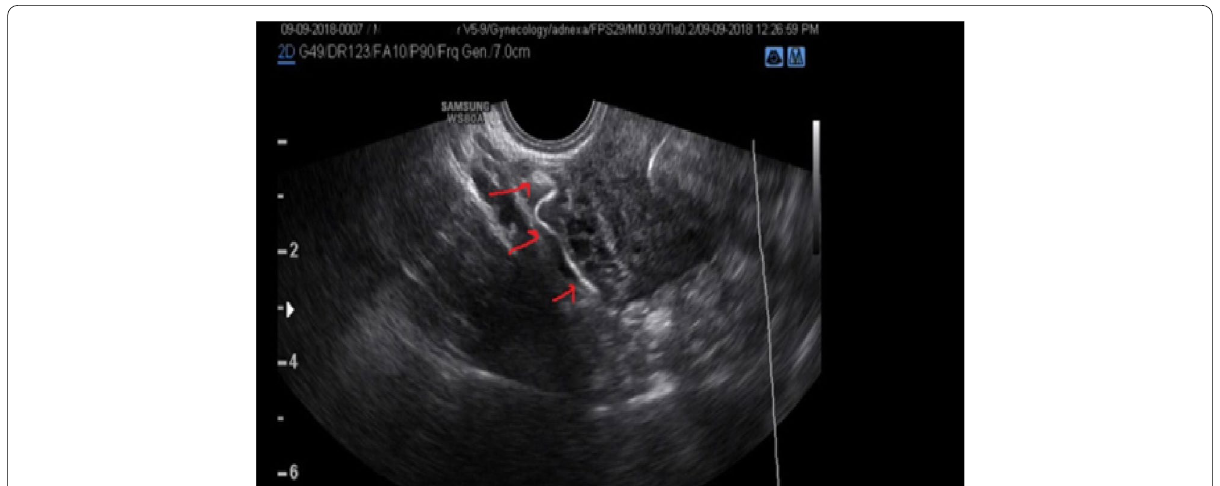
Fig. 1 Whole right tube is visualized until the fimbrial end with an evident distal spill of foam